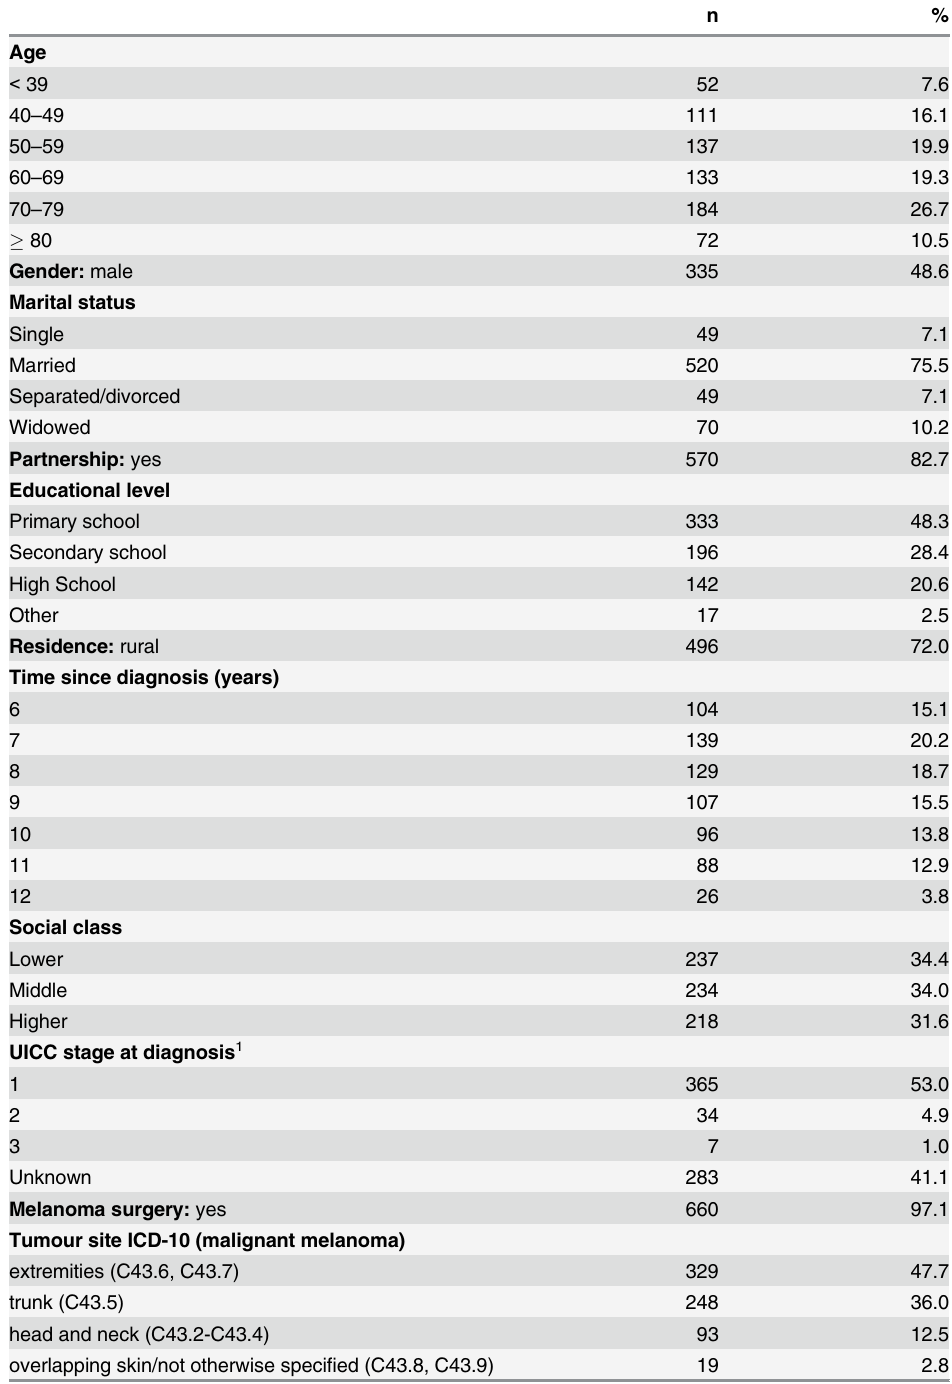
Table 1. Demographic and medical characteristics of the sample (n =